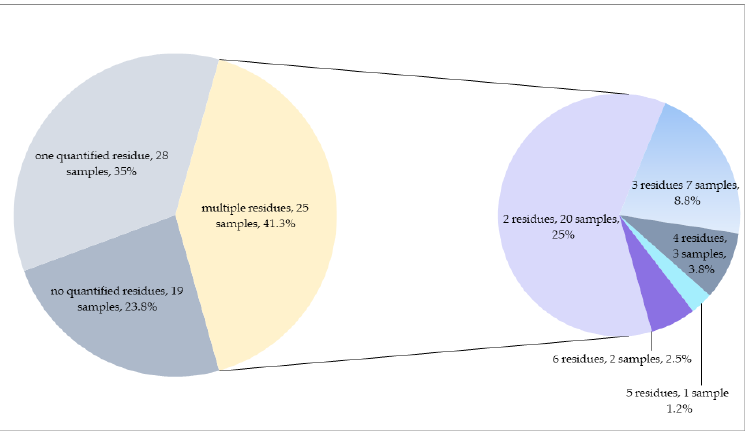
Figure 4. Number of quantified residues in rocket